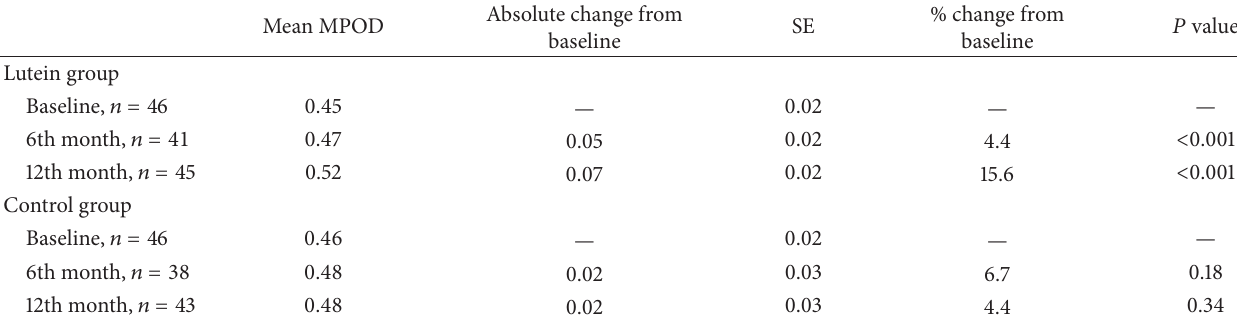
Table 3: Mean changes in MPOD in lutein and control groups during the time course of the study.